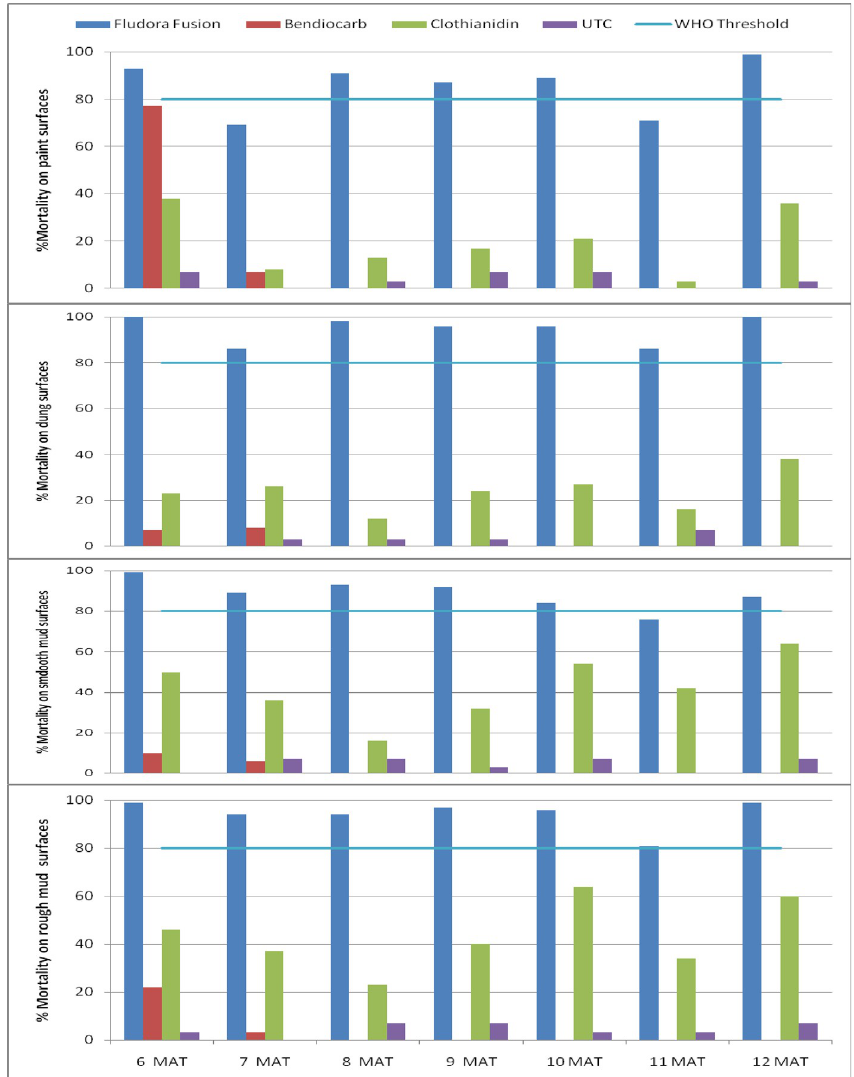
Fig 3. Residual activity of insecticides against susceptible Anopheles arabiensis on four surface types of simple huts wall cone bioassays at 48 hours holding time post exposure,